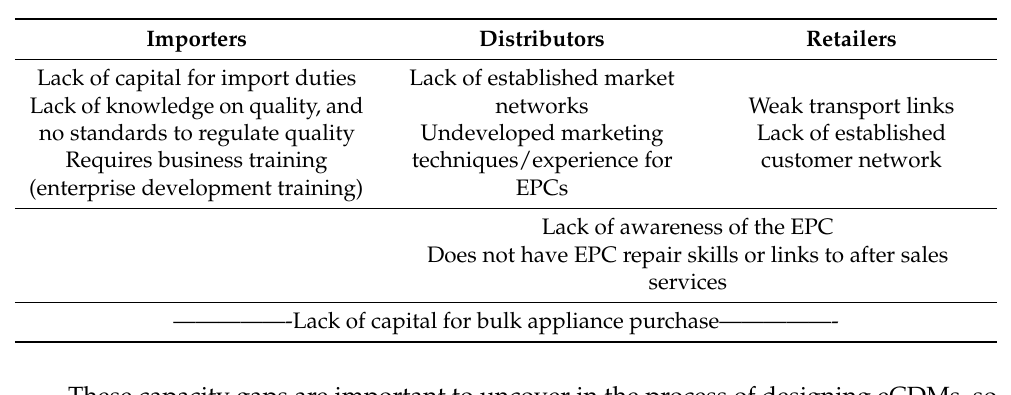
Table 6. Capacity gaps of market chain